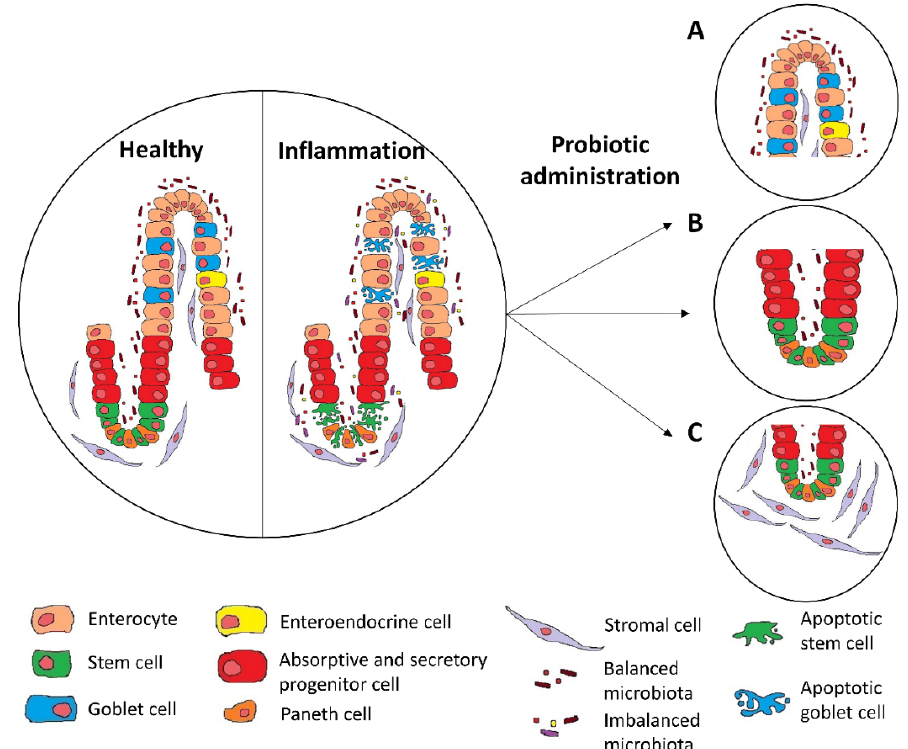
Figure 1. Probiotic administration under inflammatory conditions results in increased goblet cells replenishment ( A ), epithelial crypt regeneration ( B ), and fibroblast migration ( C